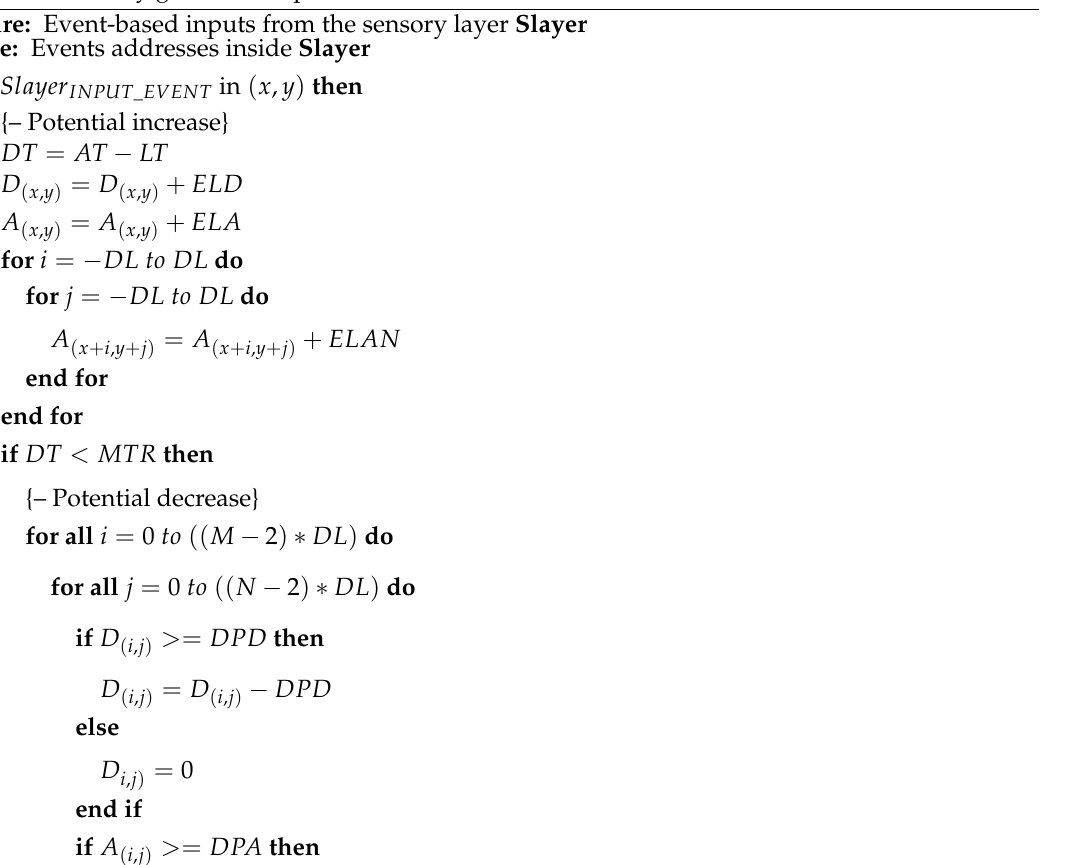
Algorithm 1 LDSI algorithm: Computation is performed when events exist in Slayer . Output events in the filter are only generated if potential is above